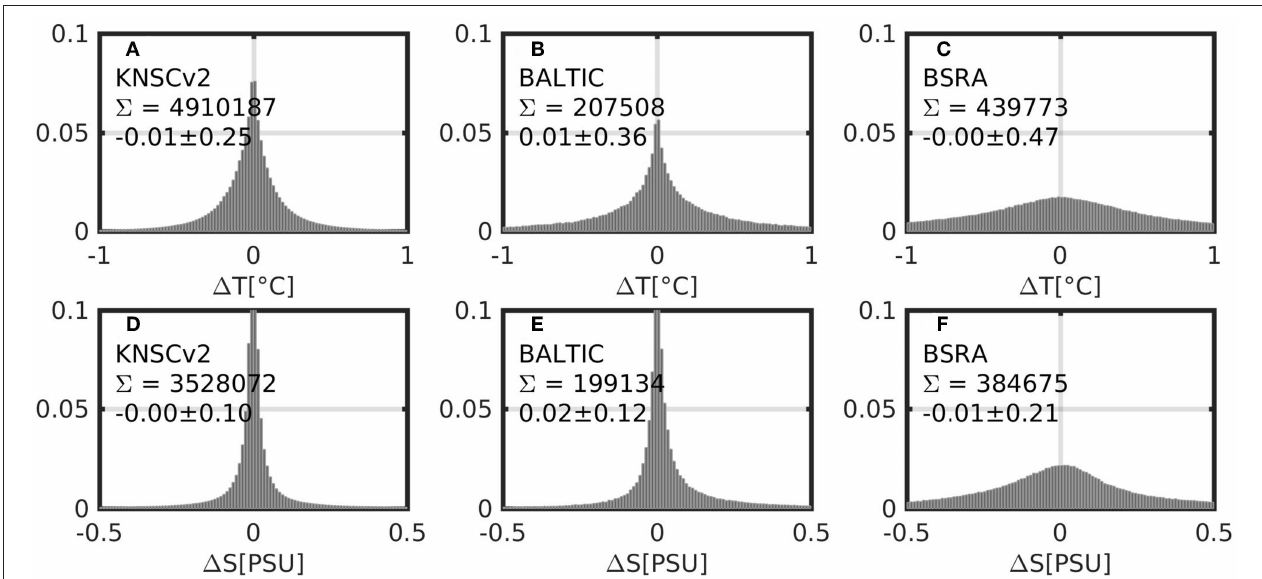
FIGURE 9 | Relative frequency distributions of absolute differences between the BNSC data product and KNSCv2 [temperature: (A) and salinity: (D) ], the Baltic ATLAS [temperature: (B) and salinity: (E) ] and BSRA [temperature: (C) and salinity: (F) ]. Additional information are the number of collocated boxes (i.e., 4910187 in the case of KNSCv2) and the mean and standard deviation of the absolute differences.